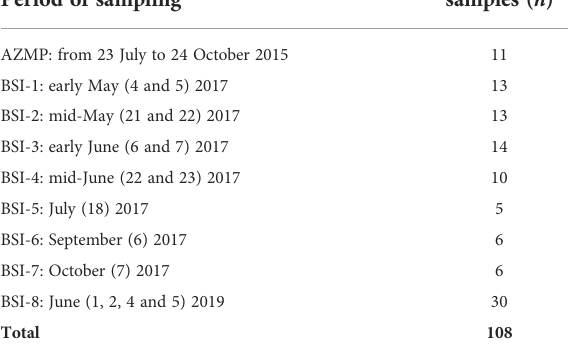
TABLE 1 Summary of the sampling strategy: Dates and number of water samples. Key to fi eld campaign location and survey: Period of